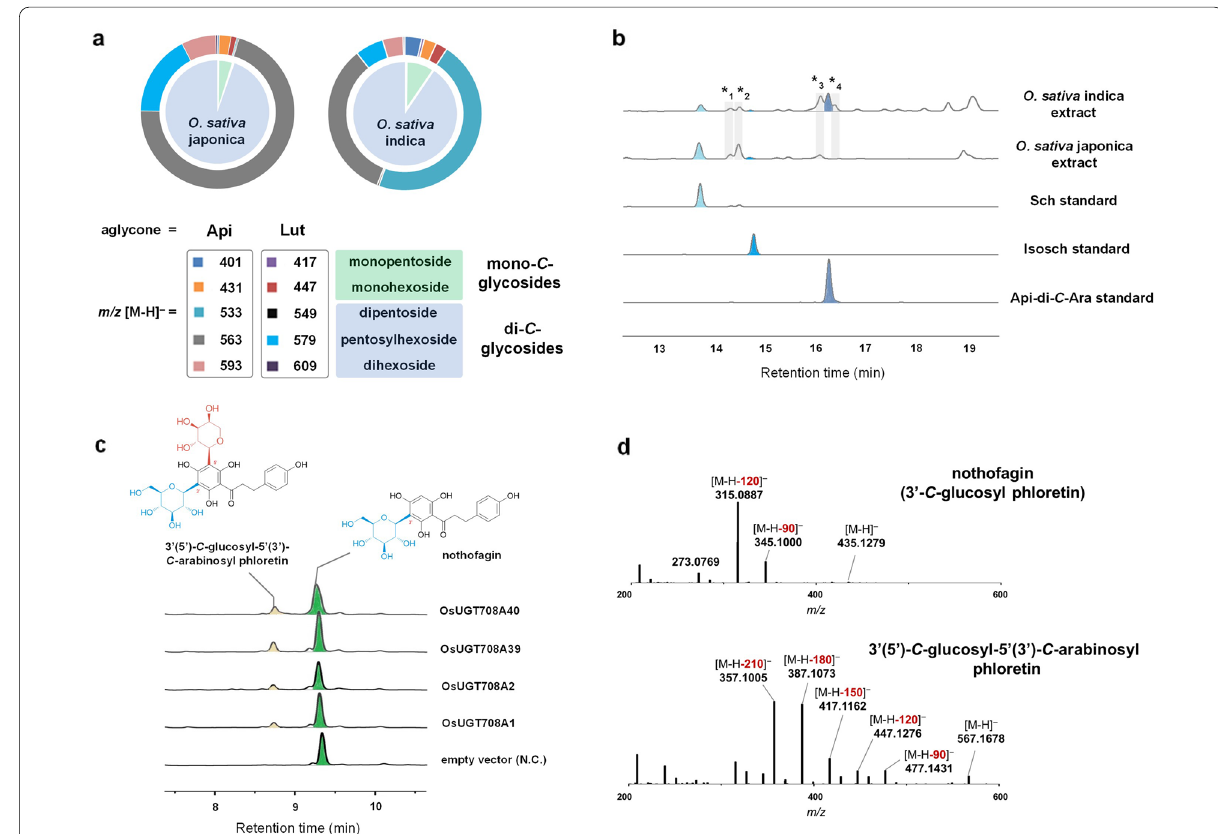
Fig. 1 Characterization of rice CGTs responsible for di- C -glycosides biosynthesis. a Composition of C -glycosides in different rice. The pie chart indicated the percentage of mono- C -glycosides and di- C -glycosides. The doughnut chart indicated individual C -glycosides of apigenin (Api) and luteolin (Lut). The ion abundance corresponding to [M–H] – peaks was calculated. b HPLC analysis of rice metabolites recorded on 280 nm. For minor diglycosides compound *1–*4, see Additional file 1: Fig S2. c HPLC chromatograms of the reactions of rice Clade B CGTs with UDP-Ara and nothofagin. d MS/MS fragmentation of nothofagin and its C -arabinosylated